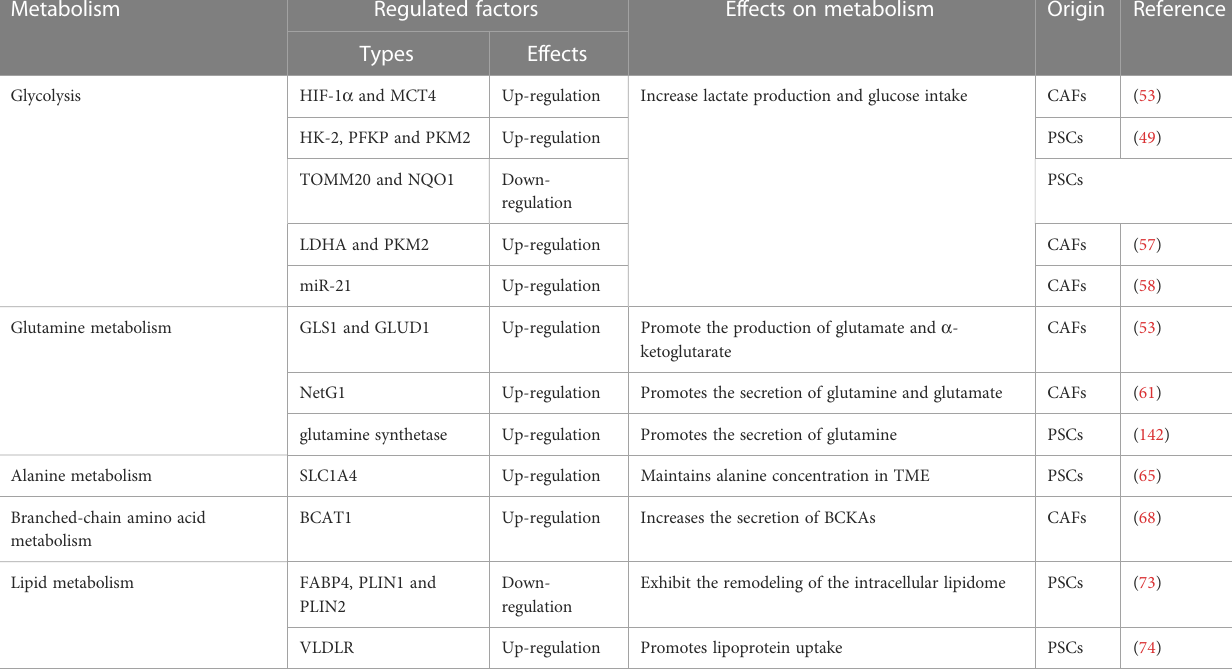
TABLE 2 Summary of CAFs metabolic reprogramming.